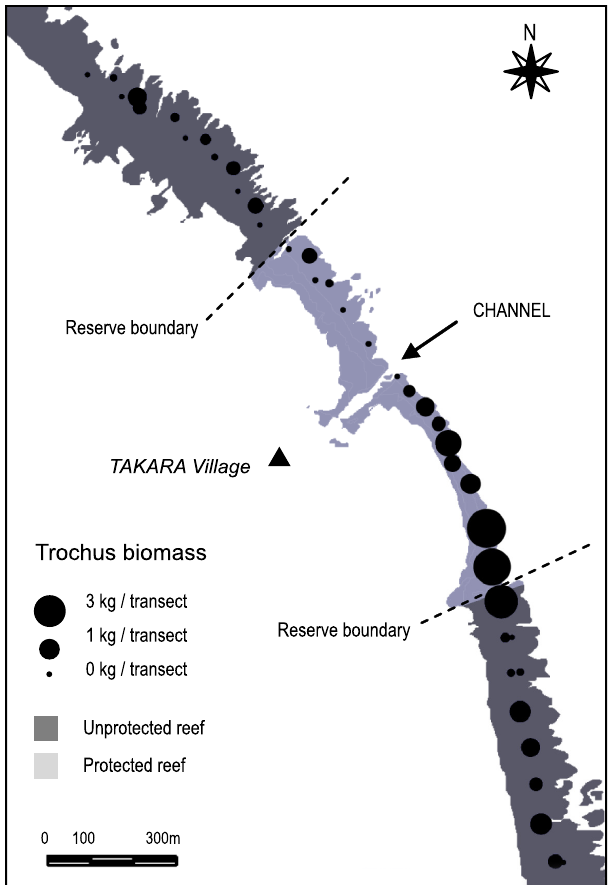
Fig 3. Spatial distribution of trochus biomass in the study area. Mean biomass(kg per station) within and outsidethe Takara reserve.